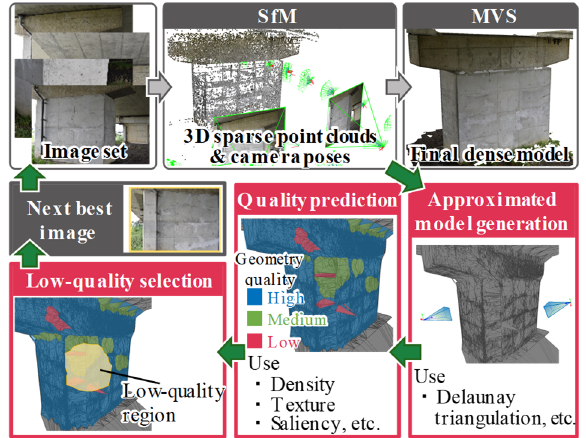
Figure 1. An overview of the proposed quality prediction